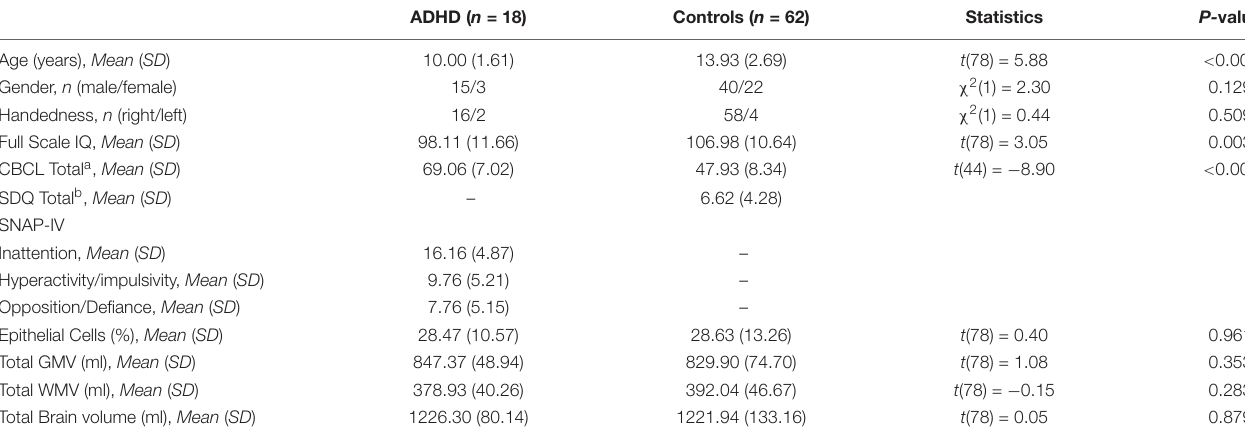
TABLE 3 | Demographic and clinical characteristics of ADHD and control